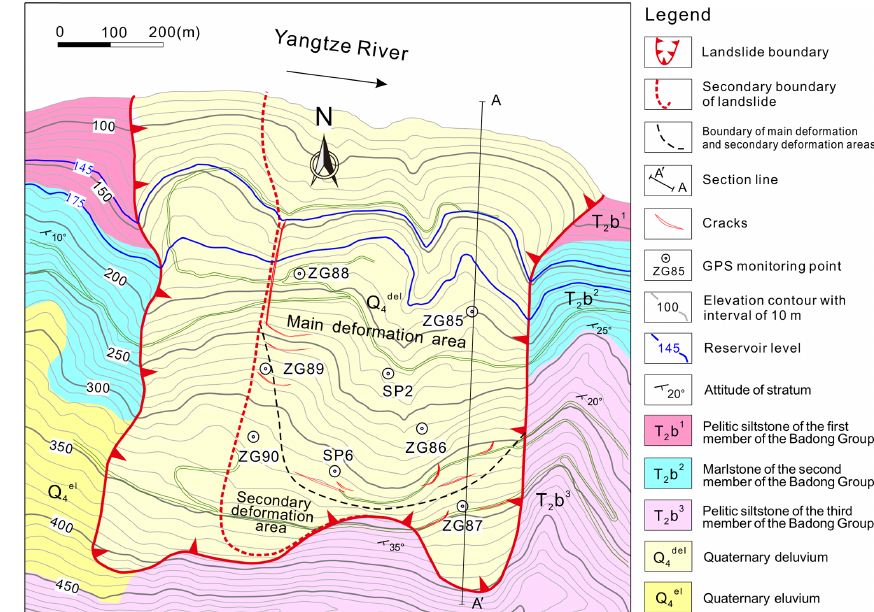
Figure 7. Engineering geology map of Shuping landslide.